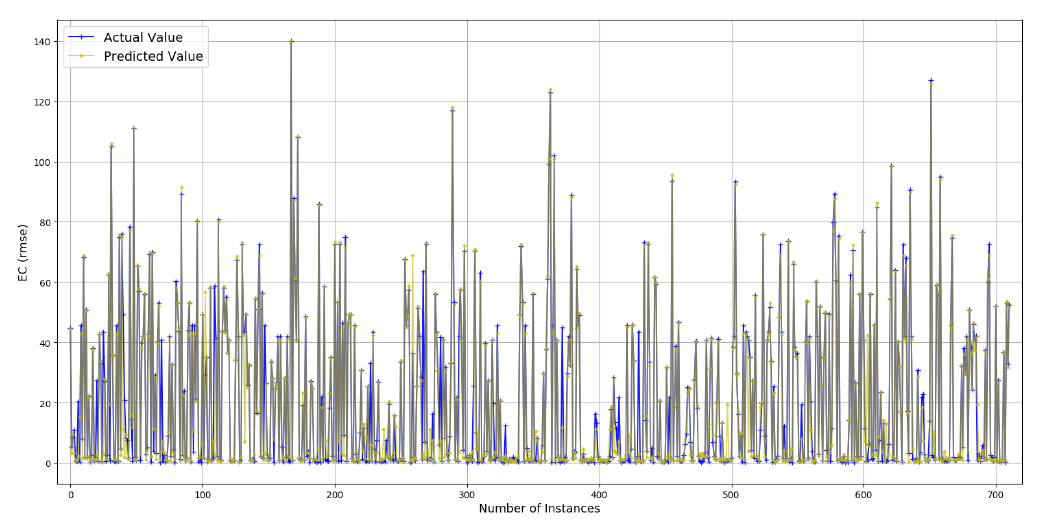
Figure 11. Actual values vs. predictions for EC sparse (selected data).